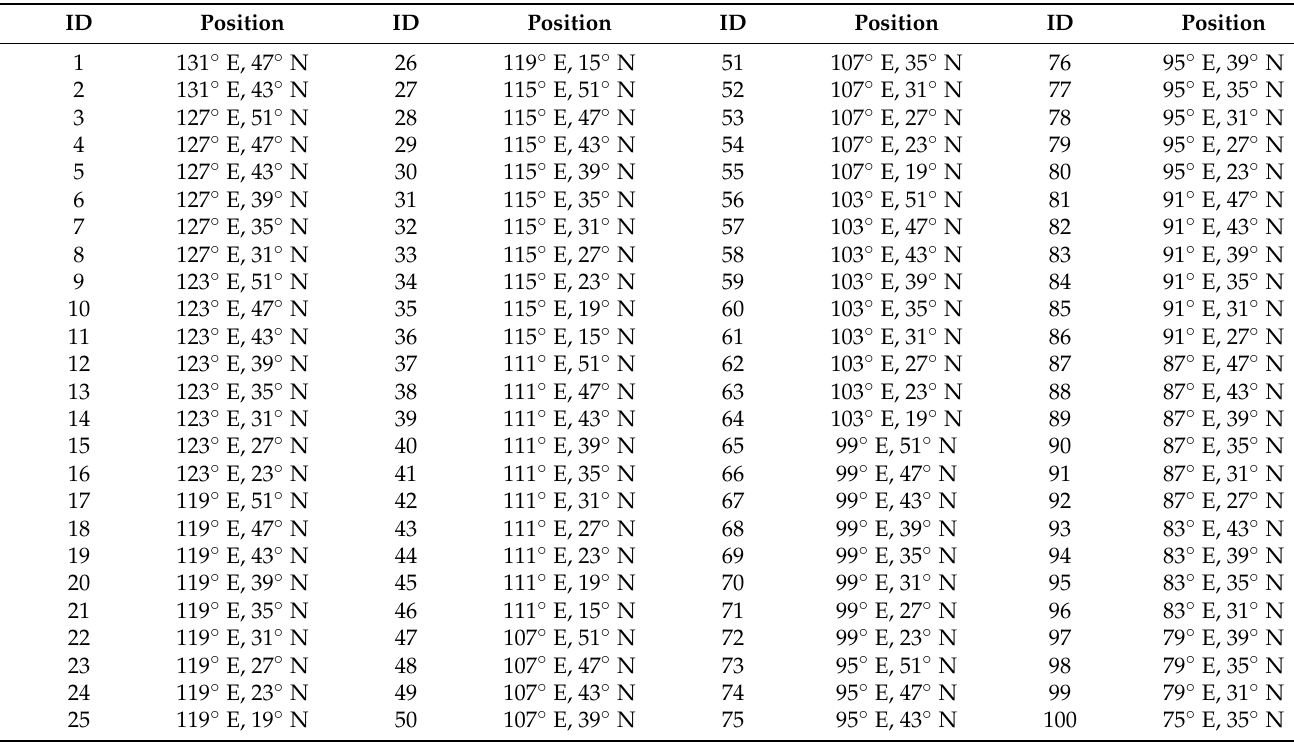
Table A2. Grid position distribution of the area target observation